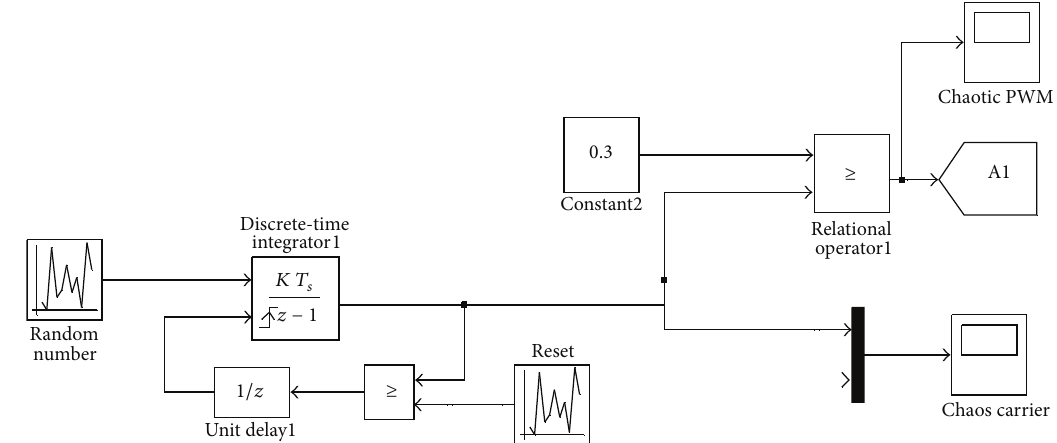
Figure 5: Chaotic PWM pulse generation.